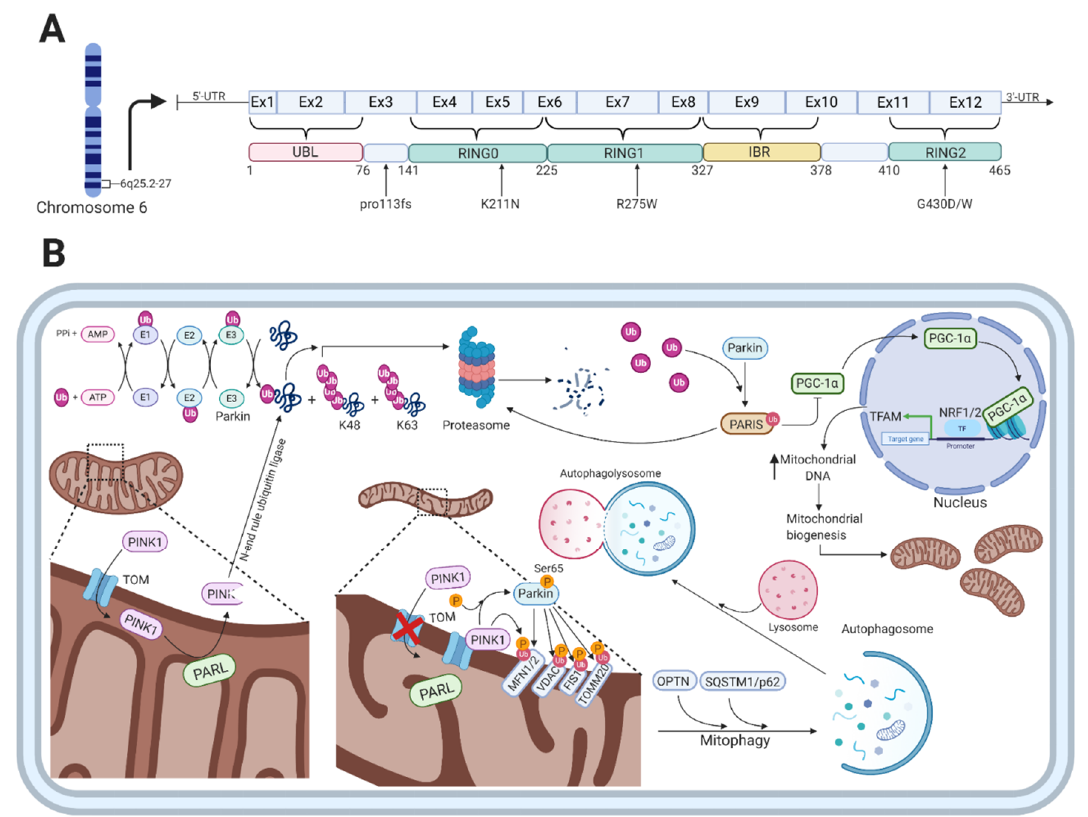
Figure 2. The function of parkin and PARK2 -related mutations. ( A ) Shows a schematic representation of parkin on transcript level, color-coded functional domains, and PARK2 -related mutations mentioned in this article. ( B ) Shows the various cellular functions of parkin, which is involved in the ubiquitin-proteasome system as an E3-ubiquitin ligase, regulation of mitophagy, and mitochondrial biogenesis. In healthy mitochondria, PINK1 is transported through the TOM complex to the inner mitochondrial membrane, which is followed by cleavage by PARL. The PINK1 protein fragment is released to the cytosol where it gets ubiquitylated by an N-end rule ubiquitin ligase for proteasomal degradation. With damaged mitochondria, PINK1 accumulates on the outer mitochondrial membrane bound to the TOM complex. This leads to PINK1-mediated phosphorylation of parkin at serine 65 in its UBL-domain that increases the activity of parkin. The ubiquitylation of proteins on the OMM by parkin includes MFN1/2, VDAC, FIS1, and TOMM20, which is sensed by autophagic cargo receptors OPTN and SQSTM1/p62. Additionally, the parkin-mediated ubiquitylation and degradation of PARIS (that normally represses PGC-1 α ) results in activation of the transcription factors NRF1/2 that will initiate the transcription of mitochondrial probiogenesis factors such as TFAM, thereby increasing mitochondrial biogenesis. Created with